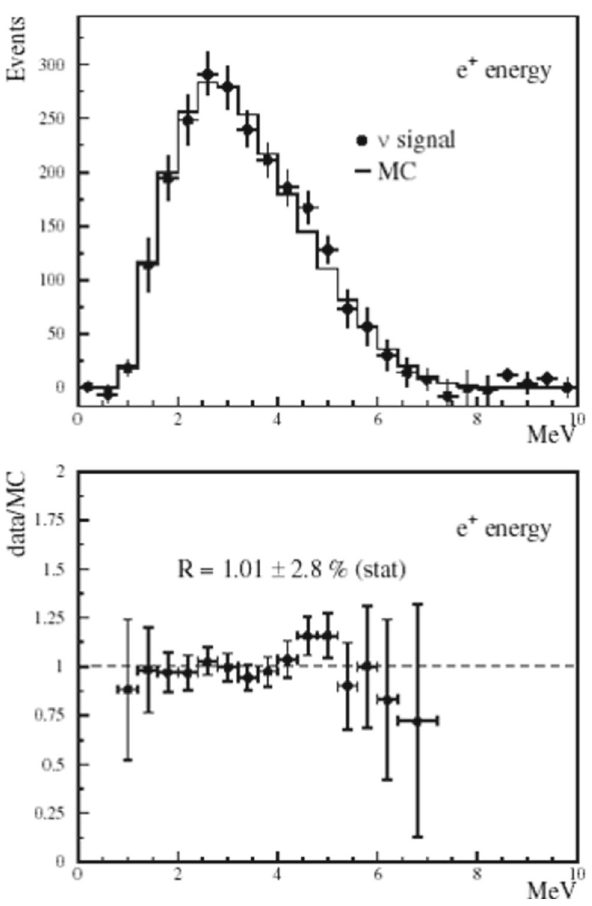
Fig. 36 Measured spectrum by the CHOOZ experiment at the distance of 1 km with 425 GWth. [49]